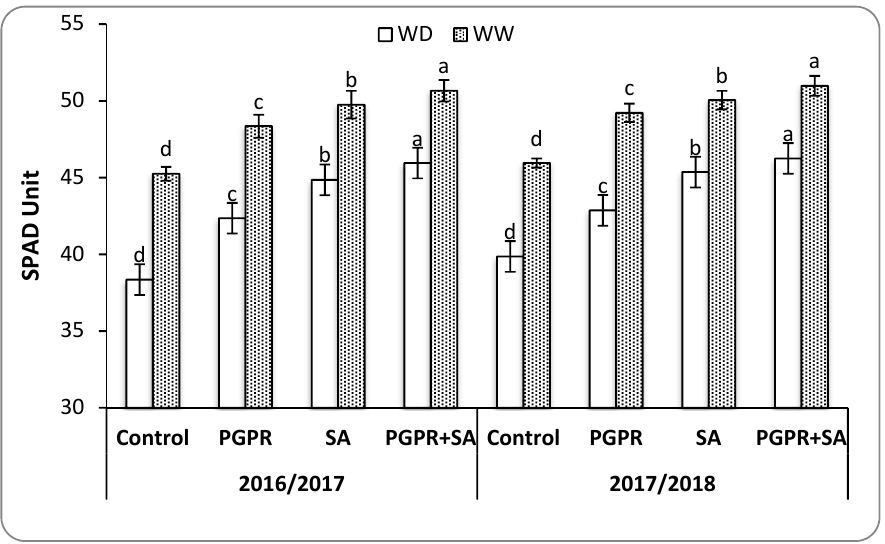
Figure 2. Effect of soil application by PGPR, foliar application by SA, and their combination on chlorophyll content (SPAD Unit) of wheat plants under water deficit conditions during two growing seasons 2016/2017 and 2017/2018. WD = water deficit (two irrigations), WW = well-watered (four irrigations). The data are the mean ± SE of three replicates; Mean values designed by the same letter in each column are not significant according to Duncan’s Multiple Range